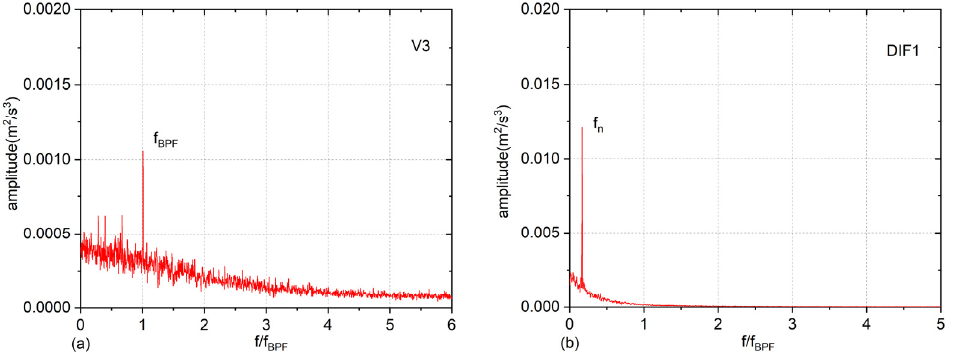
Figure 8. Velocity spectra at points V3 and DIF1 at the rated operation condition, ( a ) velocity spectrum at point V3 and ( b ) velocity spectrum at the DIF1.